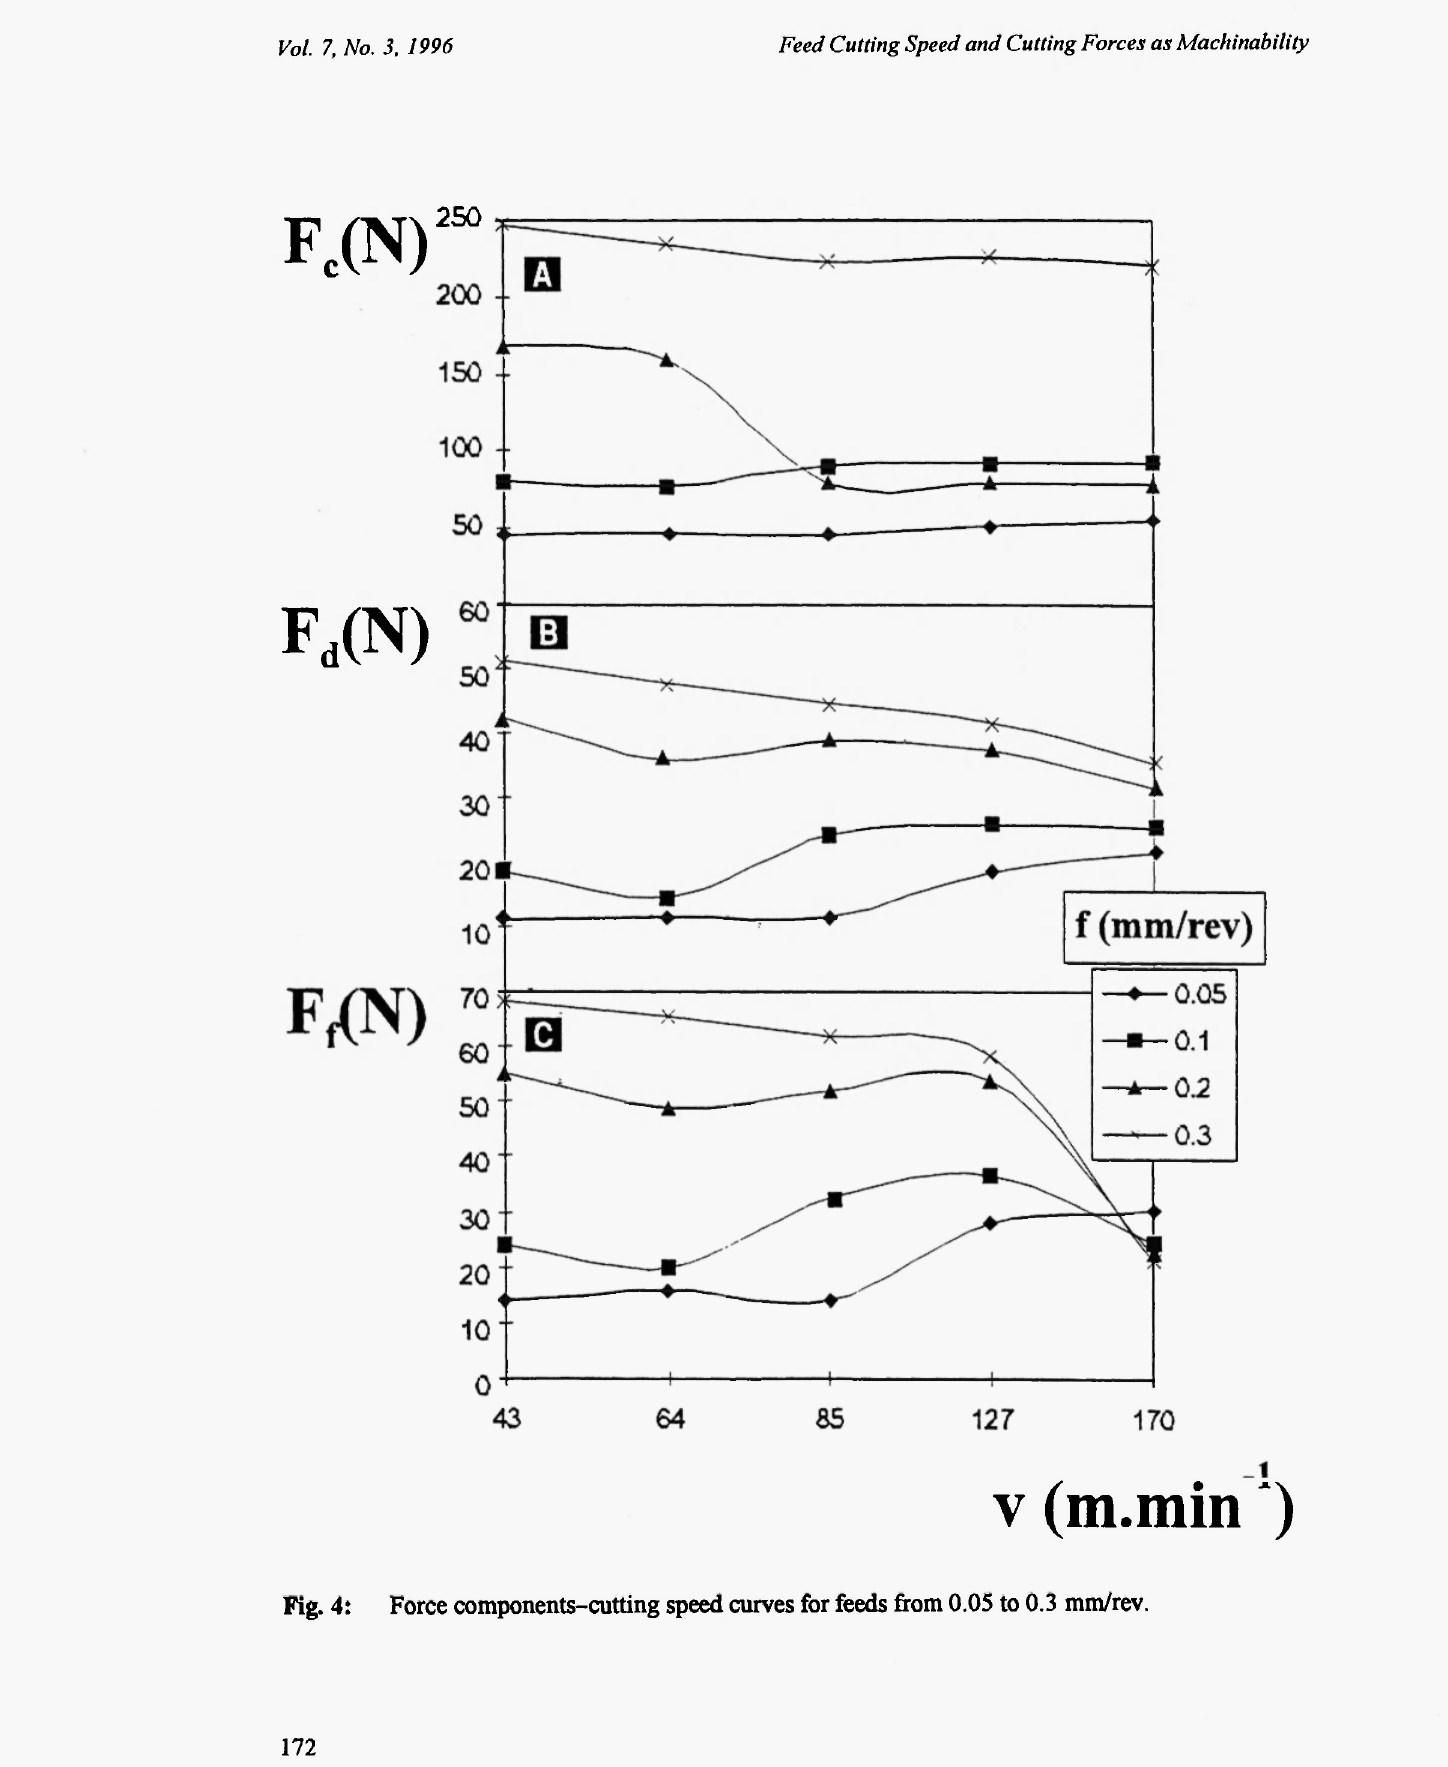
Fig. 4: Force components-cutting speed curves for feeds from 0.05 to 0.3